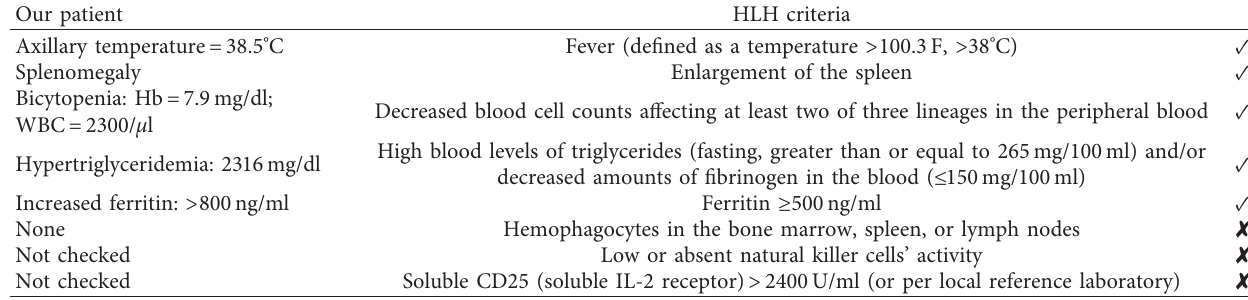
Table 2: HLH diagnostic criteria.